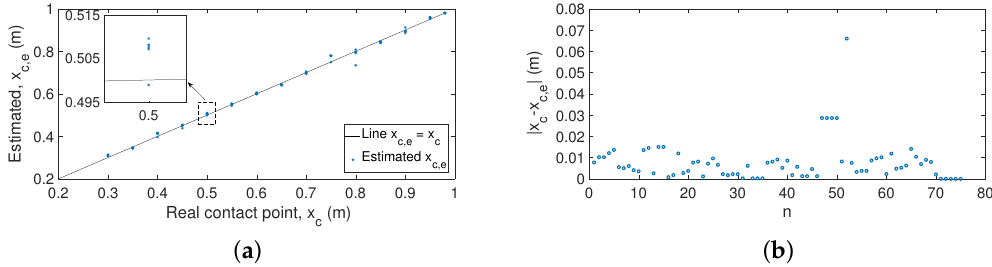
Figure 17. Experimental results obtained for the estimation of the contact point for Case 2: ( a ) estimated x c , e versus real x c ; ( b ) absolute